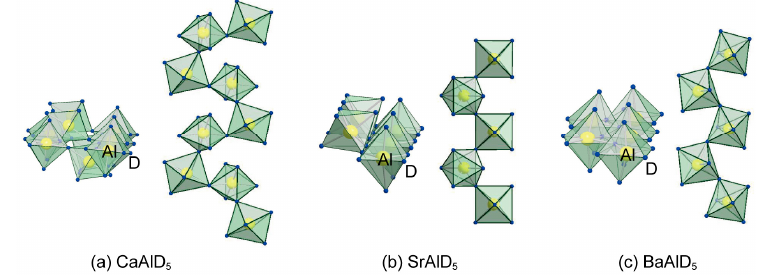
Figure 2. Corner-sharing AlD 6 octahedron chains viewed from ( left ) along and ( right ) perpendicular to the chains in ( a ) CaAlD 5 , ( b ) SrAlD 5 and ( c ) BaAlD 5 (Al: yellow sphere; D: blue sphere).